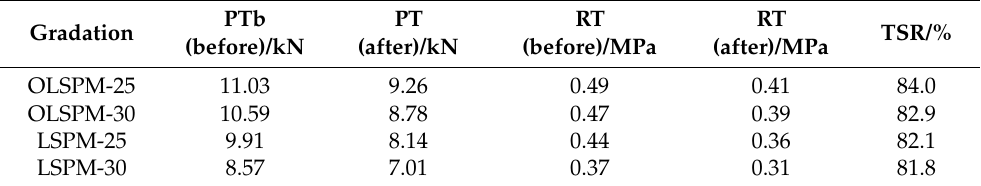
Table 6. Experimental results of freeze-thaw splitting.